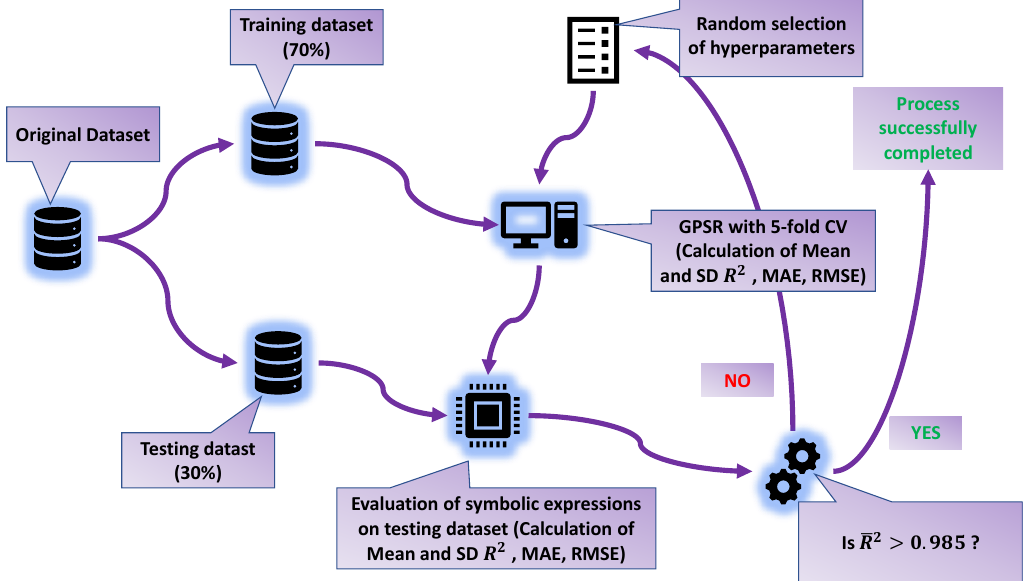
Figure 5. The flowchart of obtaining symbolic expressions using the GPSR algorithm. Due to a large number of samples (7157), the original dataset after preprocessing with StandardScaler (only input variables) was divided into a 70:30 ratio: 70% of the dataset was used in the 5-CV and the remaining 30% for the final